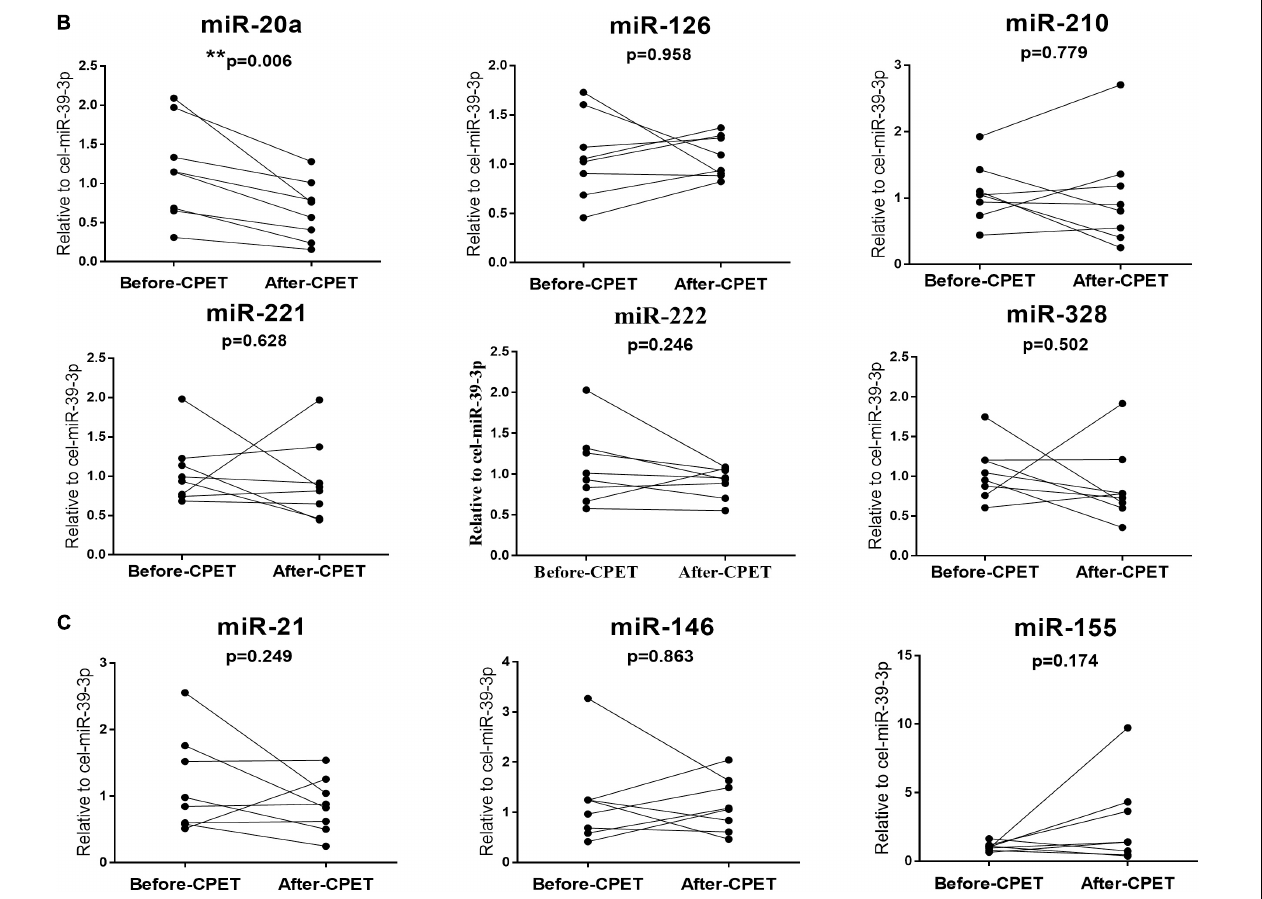
FIGURE 1 | Distinct regulatory profiles of selected circulating miRNAs before and after CPET. (A) Serum levels of cardiac or muscle-specific/enriched miRNAs before and after CPET. (B) Serum levels of angiogenesis-related miRNAs before and after CPET. (C) Serum levels of inflammation-related miRNAs before and after CPET. ** P < 0.01; n =